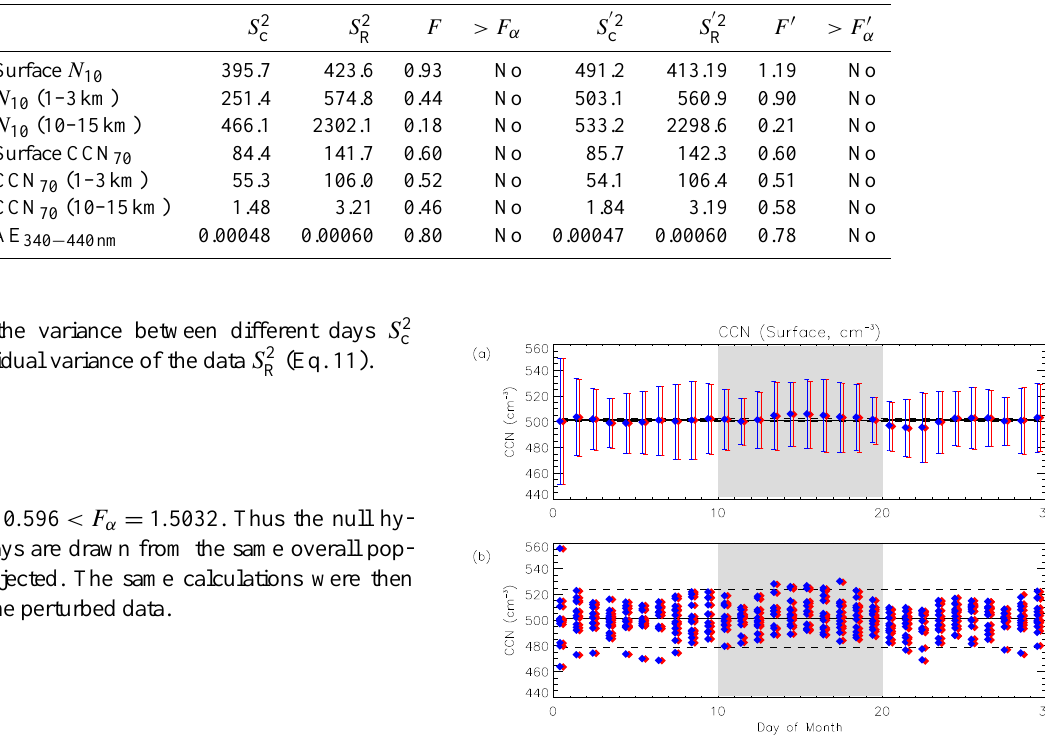
Fig. 4. Surface-level CCN. In both parts of each plot, the solid hori- zontal line shows the mean of all 360 measurements. Blue diamonds represent unperturbed values, and red diamonds represent perturbed values. (a) The dashed horizontal lines show the uncertainty on the mean, as given in Eq. (7). The diamonds show the daily means, and the error bars show the 95% confidence interval of the distri- bution between the months on that day, as given in Eq. (6). The ensemble mean is always within the 95% CI for both perturbed and unperturbed runs. (b) The dashed horizontal lines show the 95% confidence internal of the ensemble, and the diamonds show each of the individual measurements on that day. The perturbed data are no more likely to fall outside this limit than the unperturbed